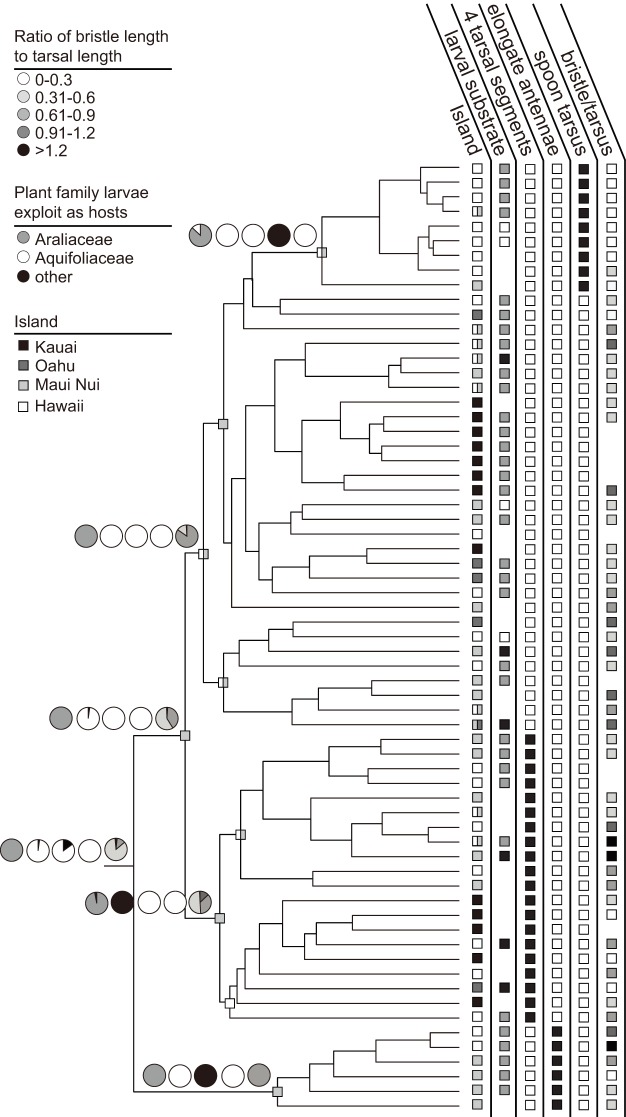
Ancestral state reconstructions. Ancestral state reconstructions of larval host substrate and secondary sexual characters in the AMC.Ancestral range reconstruction estimated under a DEC model and the most likely range is plotted on each node. Pie charts on nodes indicate probability of each state in same order as they are presented to the right of the phylogeny.